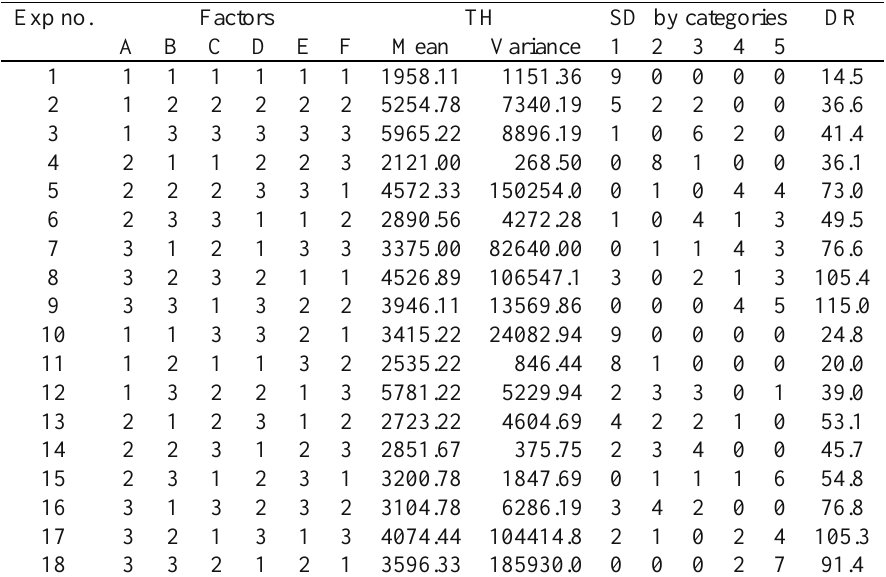
Table 1. Summarized experimental data of polysilicon deposition process